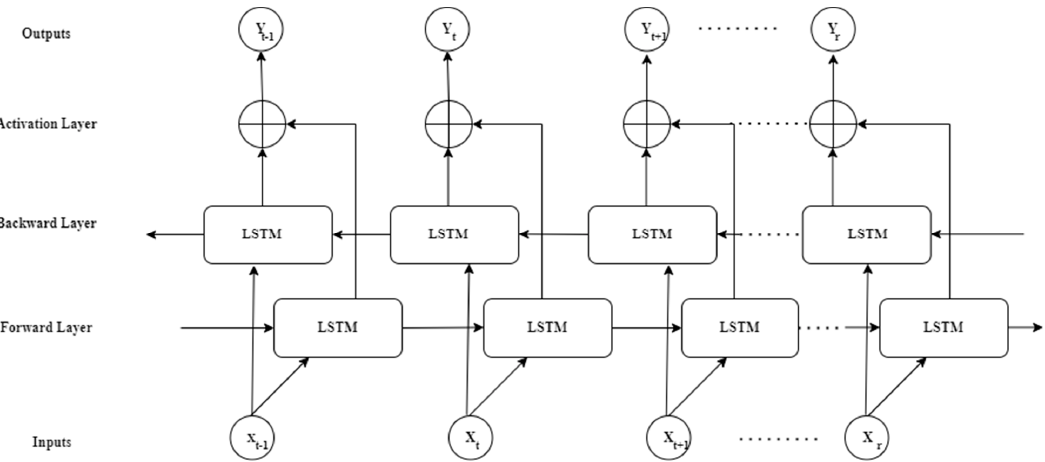
Figure A4. Model architecture of BiLSTM.